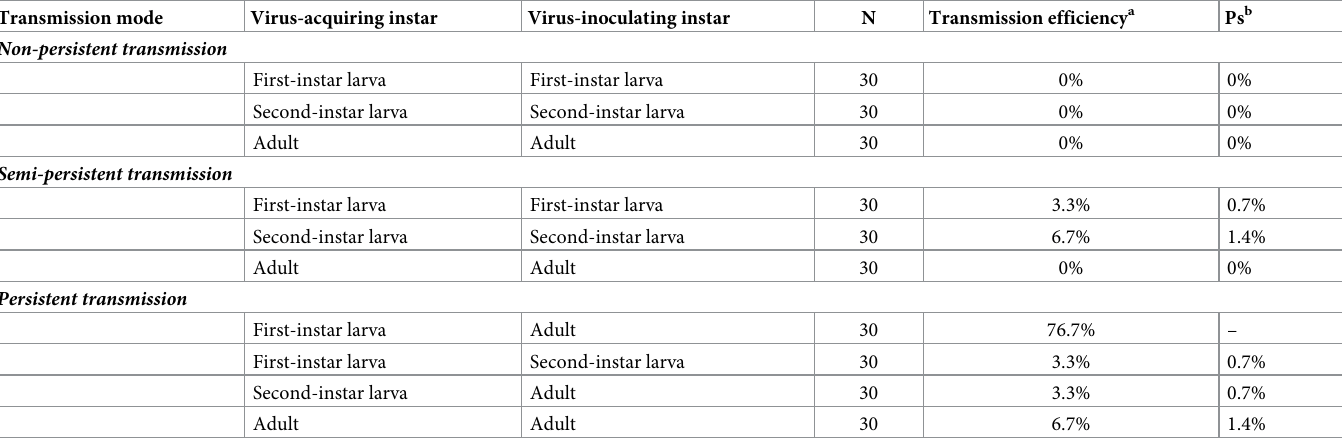
Table 1. Transmission mode and transmission efficiency of watermelon silver mottle virus by Thrips palmi